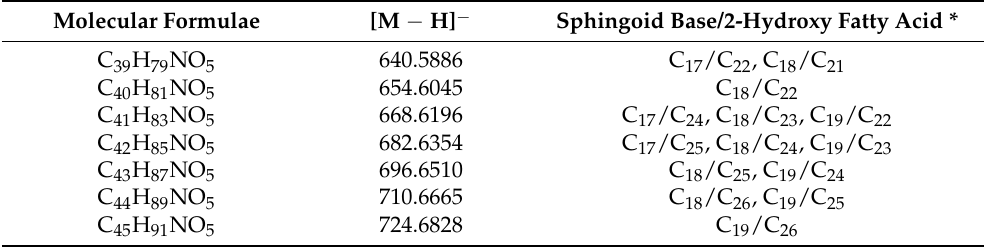
Table 2. Ceramide molecular species of M. clathrata